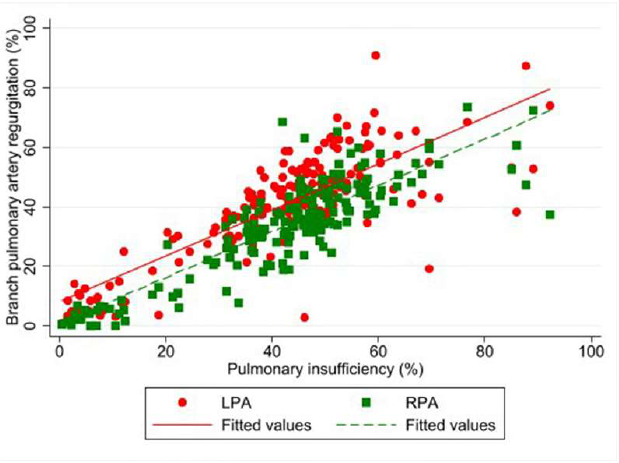
Figure 5. Correlation between pulmonary insufficiency and branch pulmonary artery regurgita- tion fraction, using linear regression analysis. fraction, using linear regression analysis.